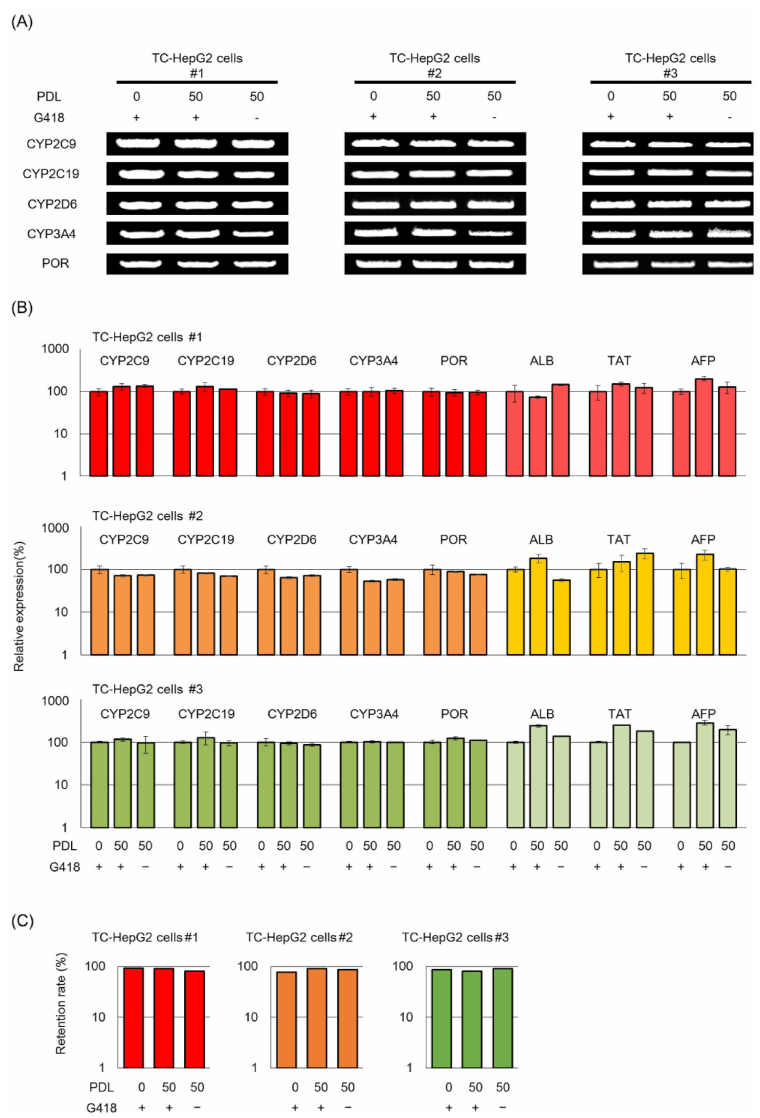
Fig 4. The 4CYPs-POR MAC stability and sustained transgene regulation in the TC-HepG2. TC-HepG2 cells were used for the followinganalysesbefore and after long-term culturing (50 PDLs) in the presence and absenceof selectionwith G418 (A-C). (A) Genomic PCR analysisof the 4CYPs-POR MAC in TC-HepG2 cells. (B) RT-qPCR analysisfor expressionof the transgenesand endogenousgenesin TC-HepG2 cells. The 4CYPs-POR transgene expressionlevels at 50 PDLs are standardized to NAT1 expression, and the relative each CYP and POR geneexpressionin each clone at 0 PDLs was used as control. Each column represents the mean ± S.E. ( n = 3). (C) FISH analysesfor 4CYPs-POR MAC stability in TC-HepG2 cells ( n = 25–30). PDL,